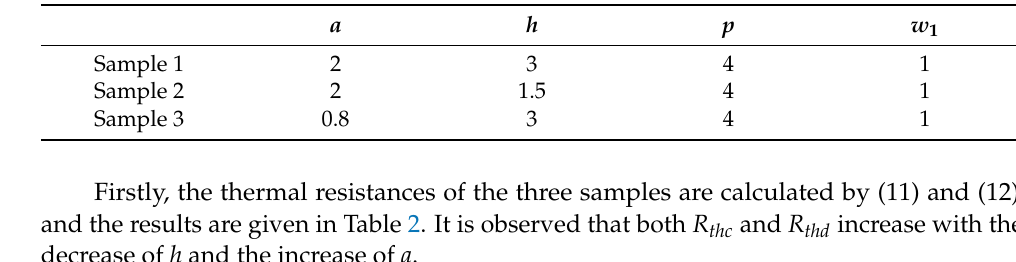
Table 1. Geometric parameters of the U-shaped corrugated SWTLs (unit: mm).